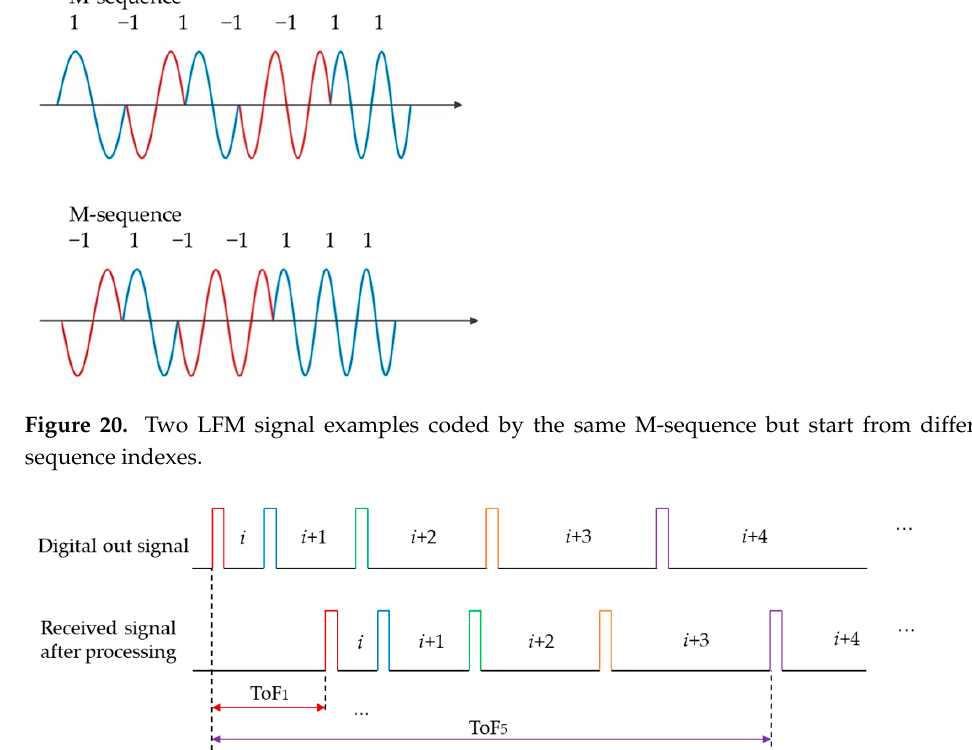
Figure 21. Pulse position modulation signals.